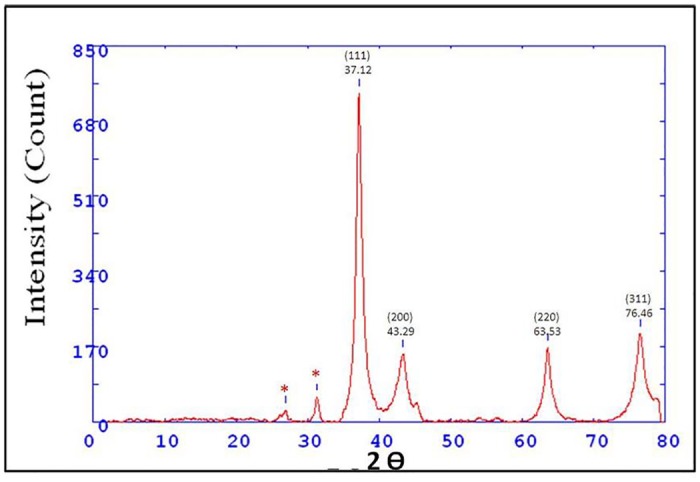
X-ray diffraction patterns of green AgNPs.